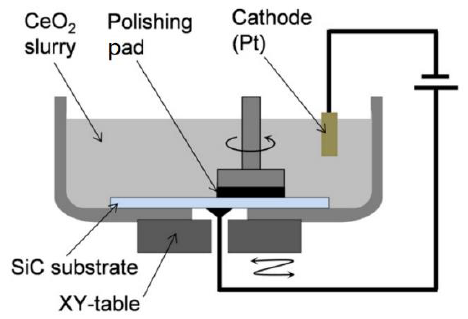
Figure 19. Schematic of ECMP setup [15]